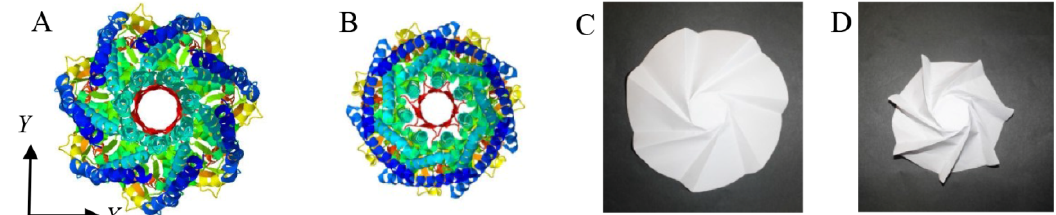
Figure 10. Auxetic iris-like mechanism of pore dilation of a mechanosensitive ion channel (MscS) and Flasher origami model. Protein structure: ( A ) open conformation of the MscS (PDB: 4HW9), and ( B ) closed conformation of the MscS (PDB: 2VV5). Origami model: ( C ) open state of the Flasher origami model, and ( D ) closed state of the Flasher origami model.